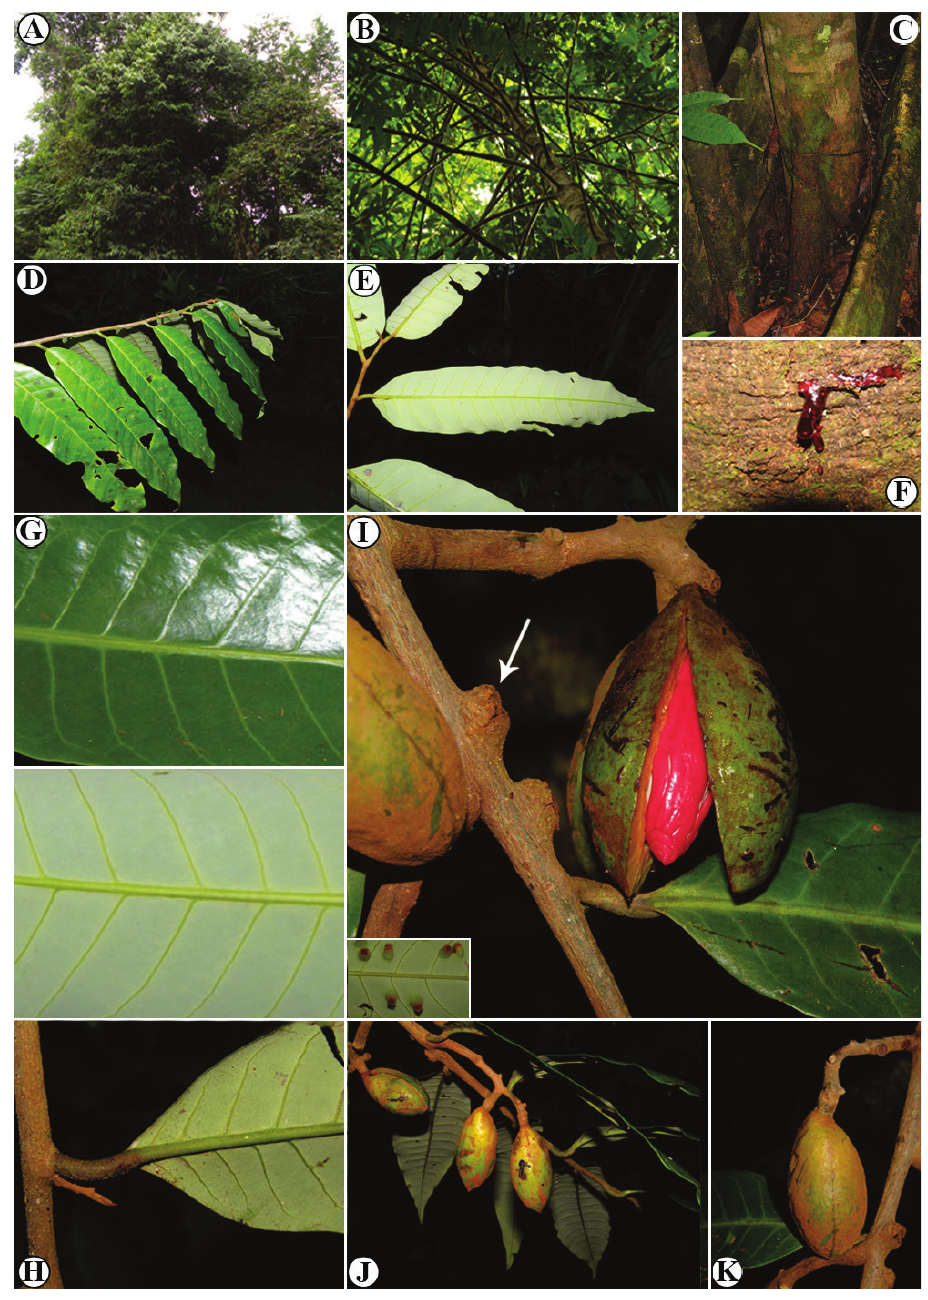
Figure 6. Virola allenii A treetop B branching C lower trunk and buttress D branch with leaves, show- ing the adaxial surface E leaf blades on abaxial surface F exudate of the trunk G leaf blade surfaces, adaxial (above) and abaxial (below) H petiole and leaf base I mature fruit, inset left and arrow showing the galls on leaves and branches, respectively J fruits K fruit close-up. Photos by Reinaldo